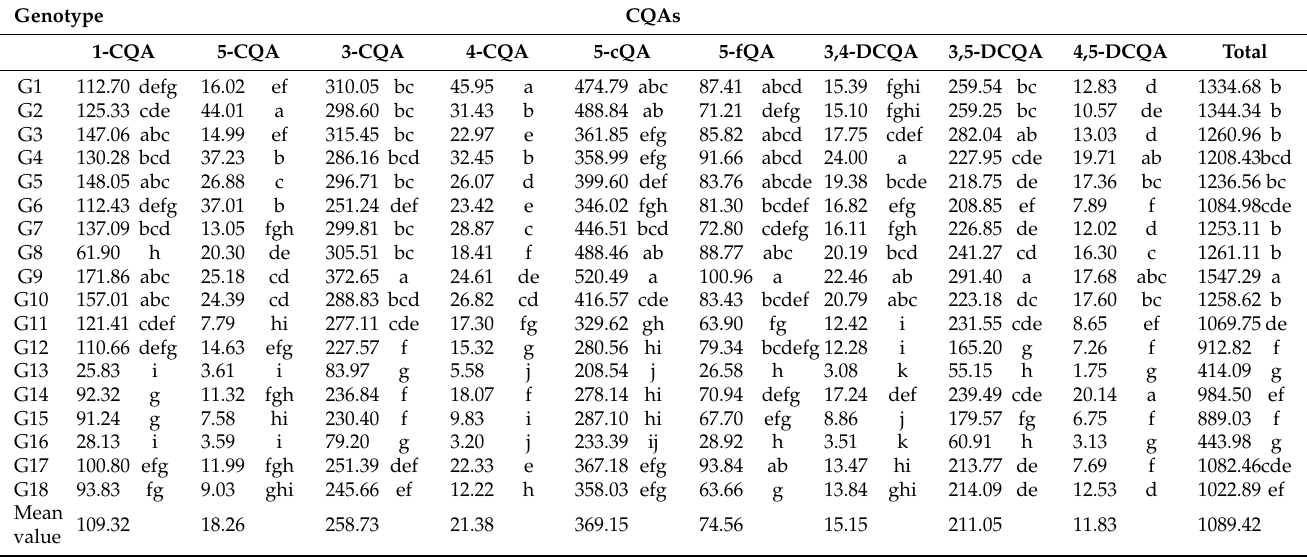
Table 4. Content (mg/100 g of dw) of main caffeolquinic acids (CQAs) of 18 native Greek rock samphire genotypes (for abbreviations and origin, see Table 1). Different letters in the same column characterize significant differences among genotypes according to Tukey’s test for p ≤